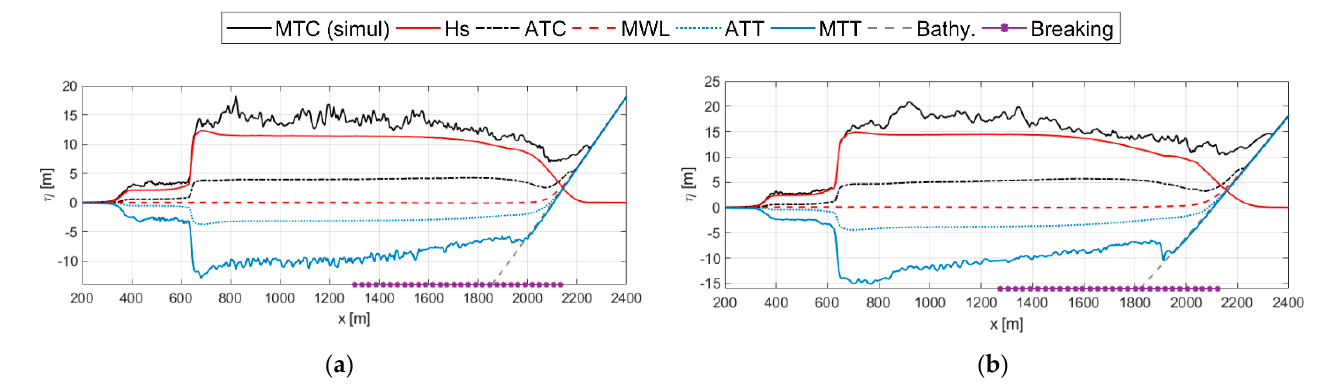
Figure 3. Wave-prints of case H12T12 in ( a ) and of H15T16 in ( b ). Early breaking for both cases near 800 m of waves with a crest height of more than 1.5 Hs was observed in the simulations; full breaking for case H12T12 is at D = 44 m, Hs/D = 0.27 and for H15T16 at Hs/D = 0.33. Table 2. For all four cases, the values of the statistical quantities and the steepness are given at 6 positions towards the shoreline; 𝛿 Hs = Hs − Hs(influx) is the deviation for each case.